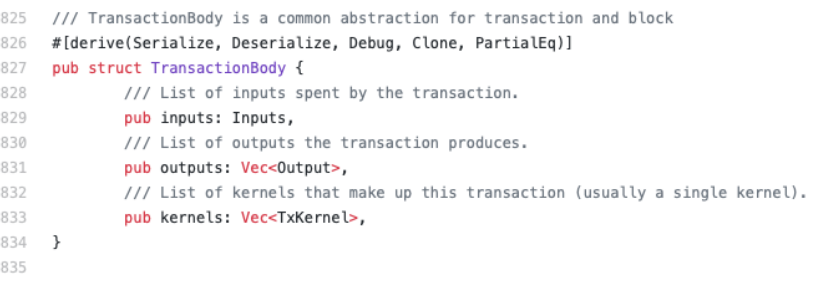
Figure A1. Grin transaction body source code [63].